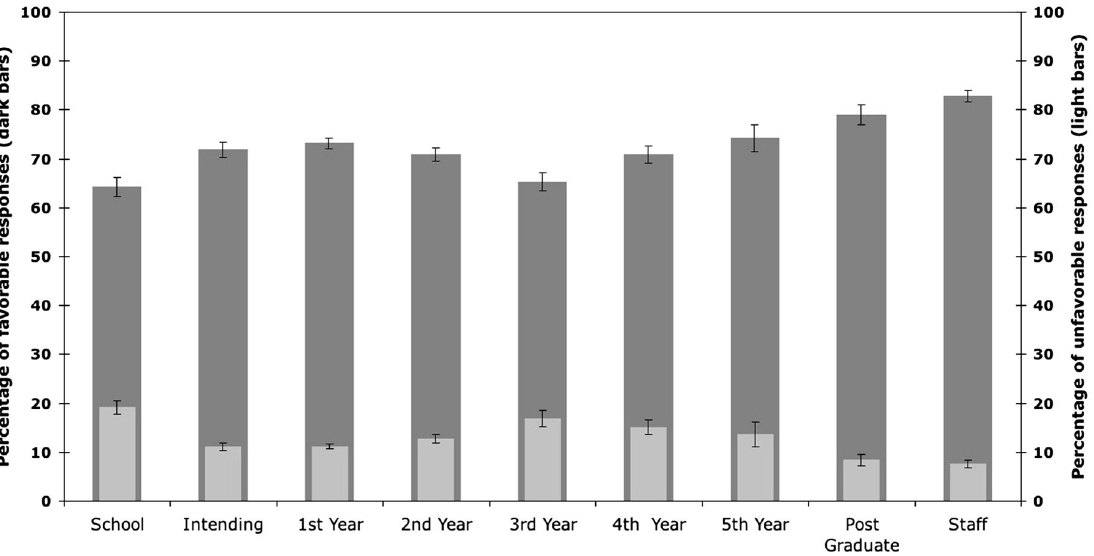
FIG. 1. Overall percentages of favorable and unfavorable responses from survey cohorts. Favorable and unfavorable responses are shown as dark and light bars,